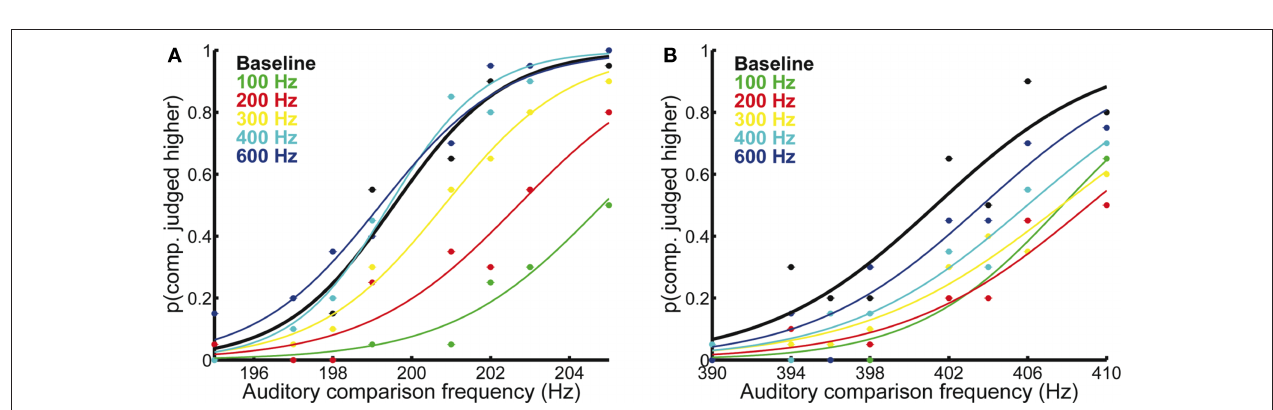
Figure S1 | Psychometric functions fit to data acquired in the frequency, intensity, and timing experiments. The data show the proportion of trials in which the frequency (intensity) of a given comparison stimulus is judged to be higher (louder) than that of a standard tone. Trace color indicates distractor